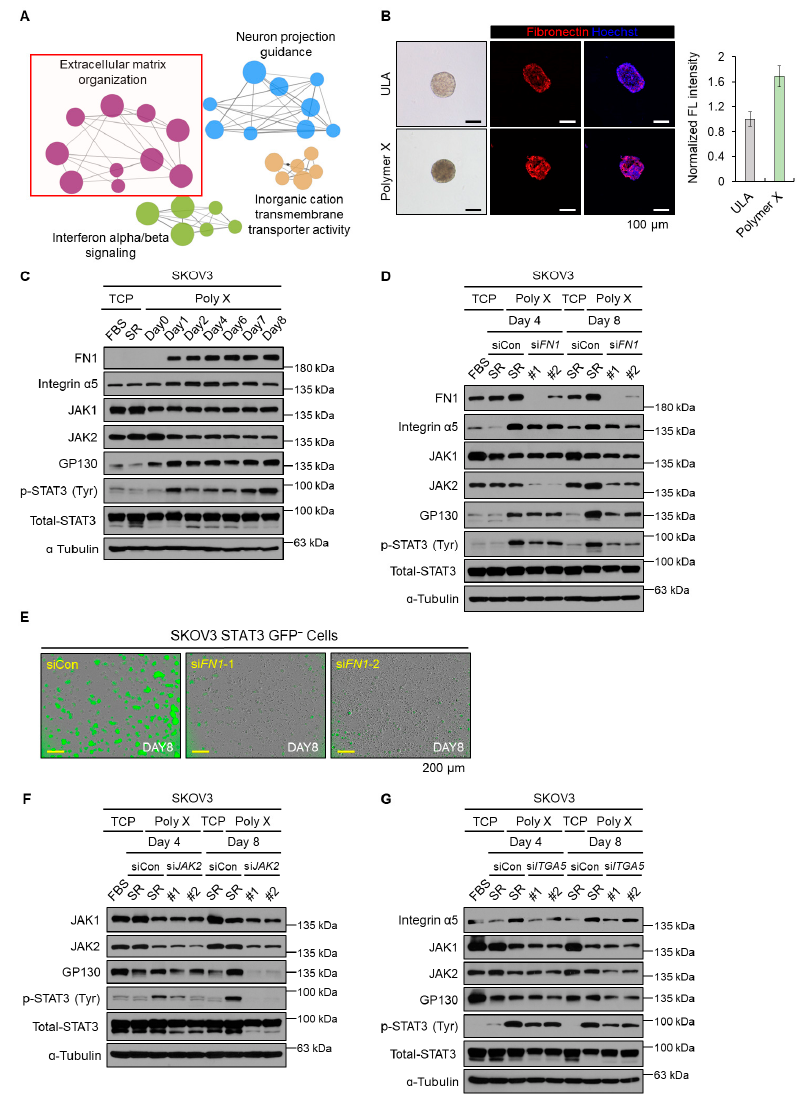
Figure 2. Initial activation of STAT3 signaling was induced by fibronectin-JAK2 axis. ( A ) Functional network analysis of Gene Ontology (GO). Significantly enriched GO terms were visualized using the Cytoscape software add-on ClueGO plugin. The Benjamini–Hochberg false discovery rate was used to analyze statistical significance. Each node represents a significantly enriched GO term. ( B ) Image obtained by SKOV3 cancer cells cultured on polymer X or ULA for 8 days, and representative image displaying IF representing fibronectin expression in 8 days of SKOV3-derived tumor spheroids cultured on polymer X or ULA. Scale bar, 100 µ m. ( C ) Cell lysates from SKOV3 cancer cells cultured on polymer X by date were immunoblotted with antibodies specific to FN1, integrin α 5, JAK1, JAK2, GP130, p-STAT3, total STAT3, and α -tubulin. ( D ) Cell lysates from SKOV3 cancer cells transfected with either non-target siRNA or si FN1 cultured on polymer X on days 4 and 8 were immunoblotted with antibodies specific to FN1, integrin α 5, JAK1, JAK2, GP130, p-STAT3, total STAT3, and α -tubulin. ( E ) Image obtained by culturing STAT3 GFP-negative cell line transfected with either non-target siRNA or si FN1 , cultured on polymer X for 8 days using IncuCyte system. Scale bar, 200 µ m. ( F ) Cell lysates from SKOV3 cancer cells transfected with either non-target siRNA or si JAK2 , cultured on polymer X on days 4 and 8, were immunoblotted with antibodies specific to JAK1, JAK2, GP130, p-STAT3, total STAT3, and α -tubulin. ( G ) Cell lysates from SKOV3 cancer cells transfected with either non-target siRNA or si ITGA5 , cultured on TCP or polymer X on days 4 and 8, were immunoblotted with antibodies specific to integrin α 5, JAK1, JAK2, GP130, p-STAT3, total STAT3, and α